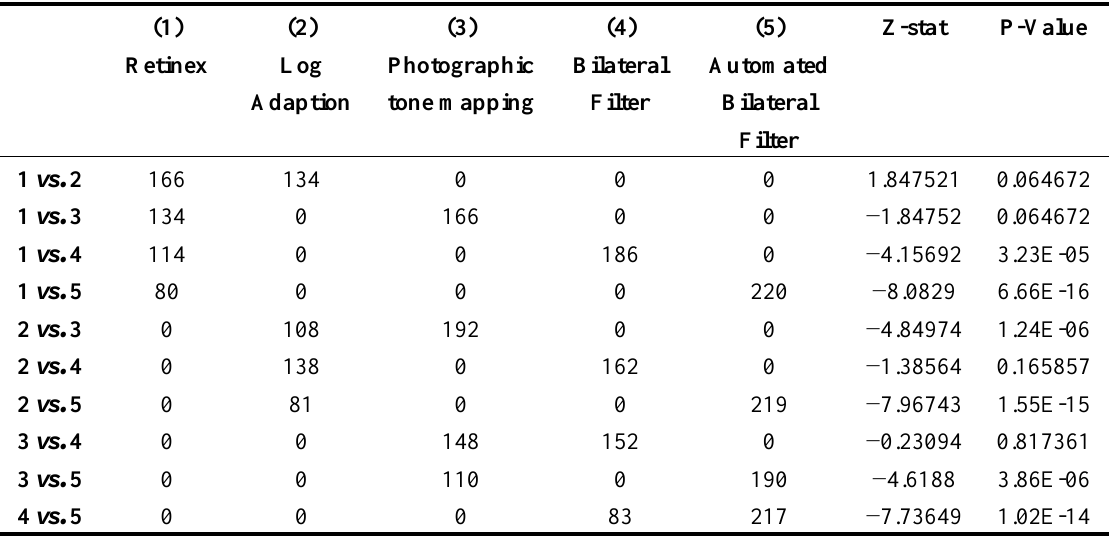
Table 2. Experiment 2 Paired Comparison Results, z-statistics and p-values collapsed across participants and